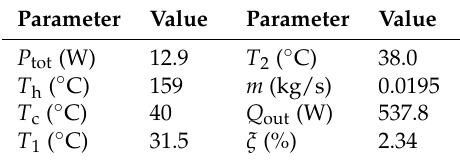
Table 3. Measured data for TE